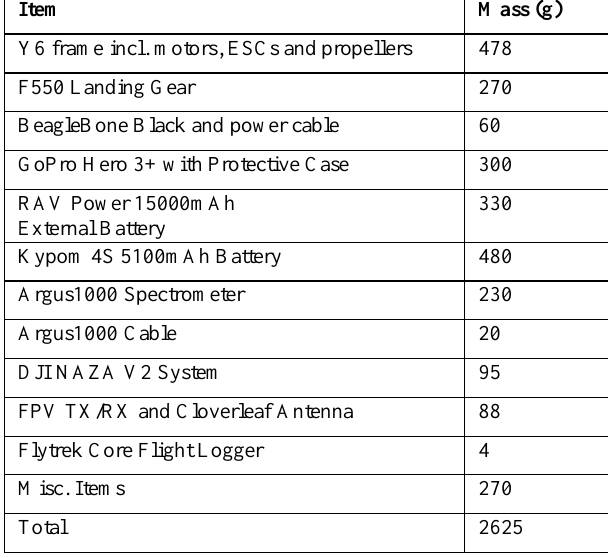
Table 1. UAV Mass Breakdown